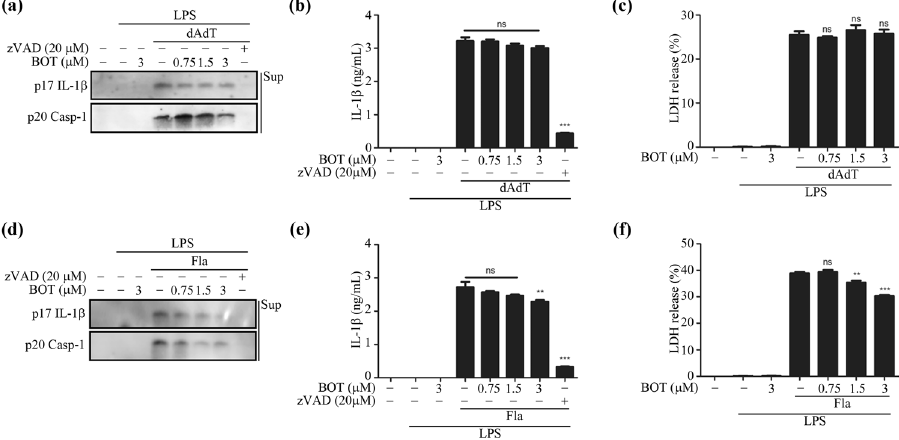
Figure 2. Effect of BOT-4-one on AIM2 and NLRC4 inflammasome activation. LPS-primed BMDMs were treated with BOT-4-one or zVAD for 1 h and then transfected with poly(dA:dT) (dAdT) or flagellin (Fla). ( a and d ) Supernatants were analyzed by immunoblot. IL-1 β secretion ( b and e ) and LDH release ( c and f ) in the cell supernatants were measured by ELISA and LDH assay, respectively. Full-length blots/gels are presented in S Fig. 9d and e. The data represent the mean ± SEM of three independent experiments; ** p < 0.01; *** p < 0.001; ns: